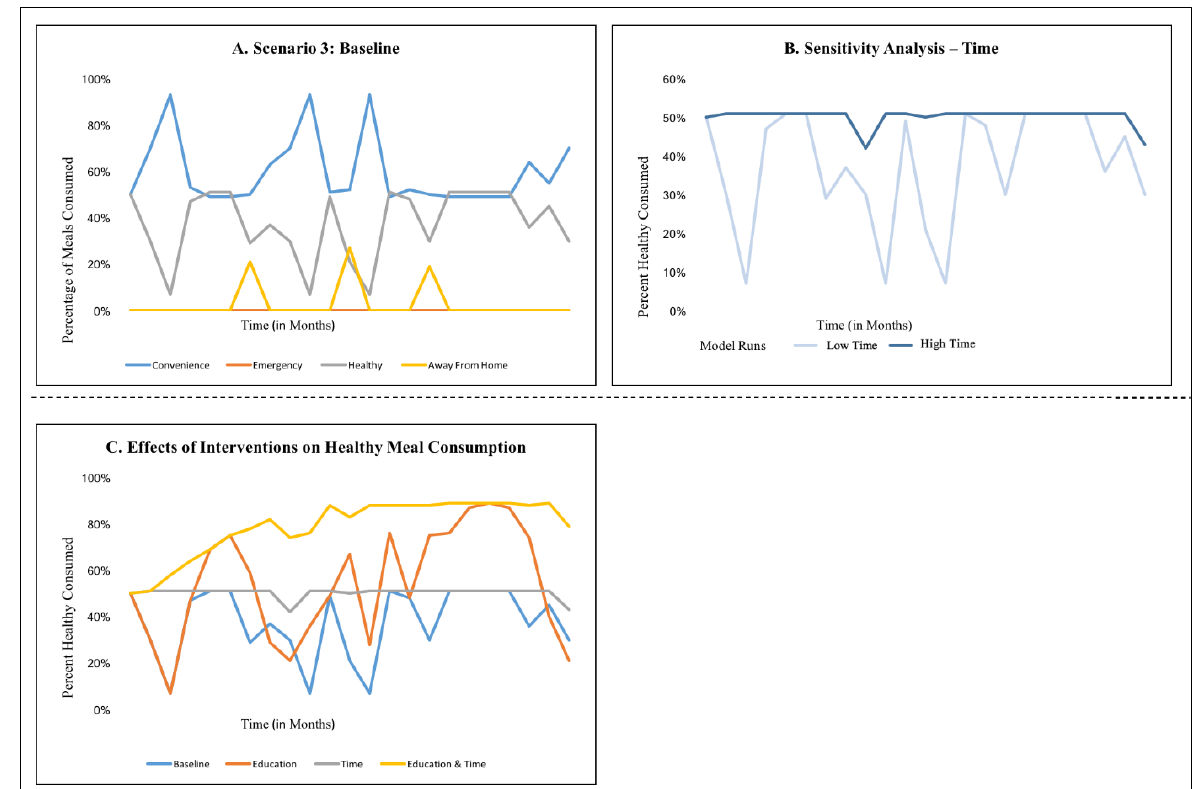
Figure 6. Scenario 3: Mid Income, Car, Variable Work